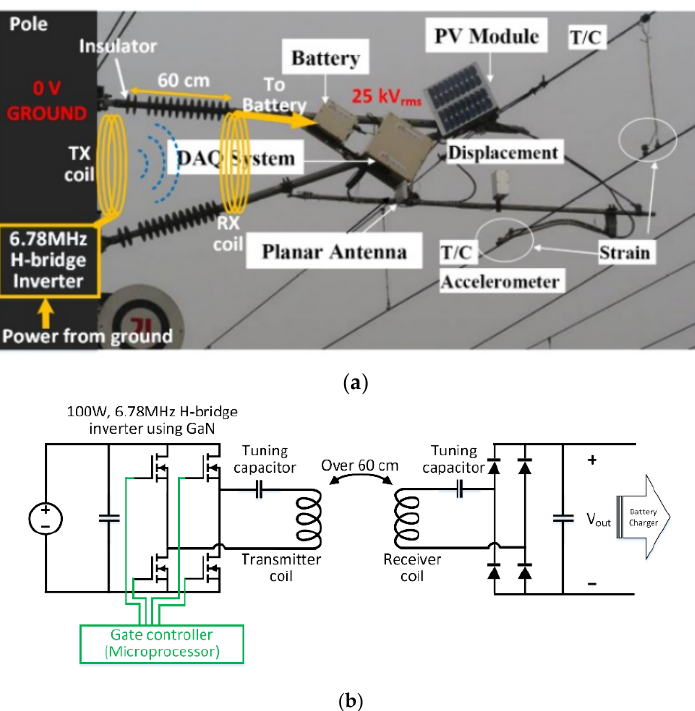
Figure 1. Configurations of the target catenary monitoring system and the WPT system: ( a ) Target system configuration; ( b ) Block diagram of the wireless power transfer system.